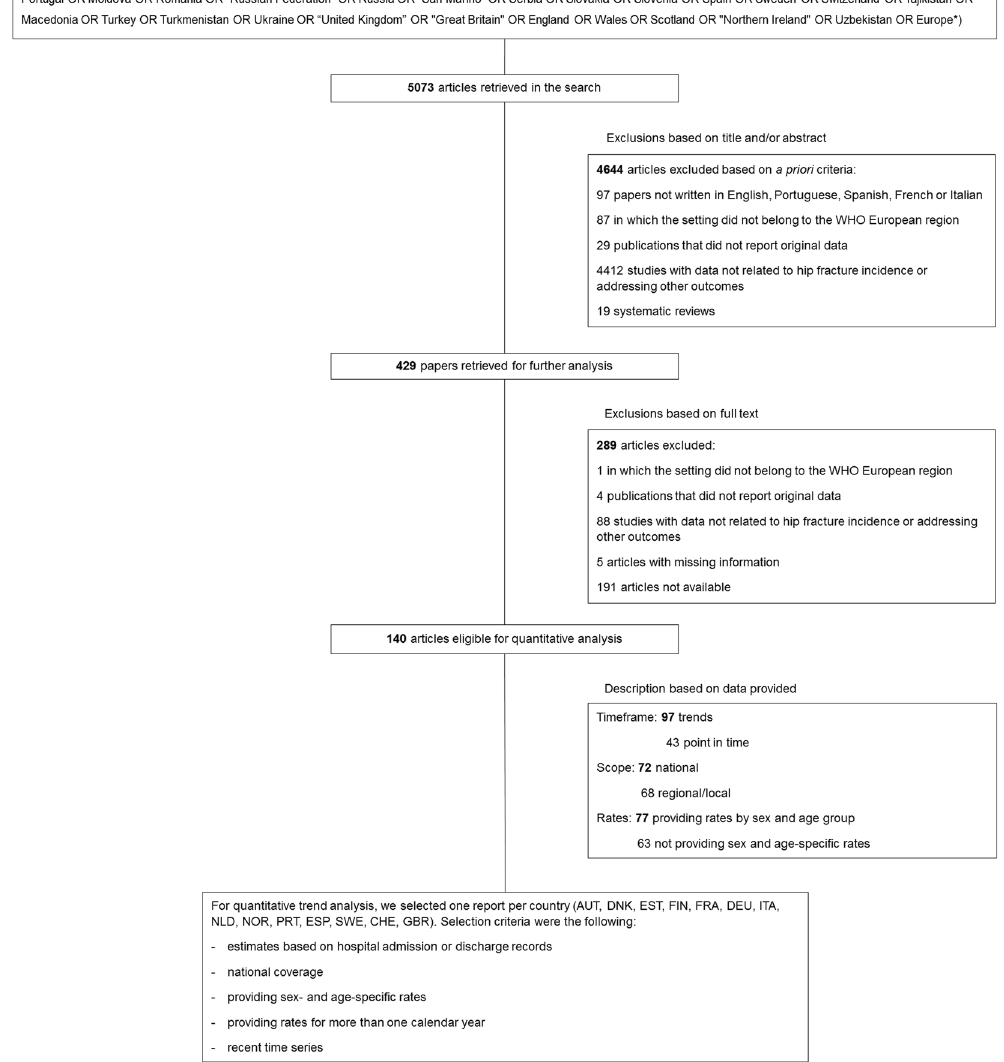
Figure 1. Flowchart of articles for data extraction. Abbreviations: WHO: World Health Organization, AUT: Austria, DNK: Denmark, EST: Estonia, FIN: Finland, FRA: France, DEU: Germany, ITA: Italy, NLD: